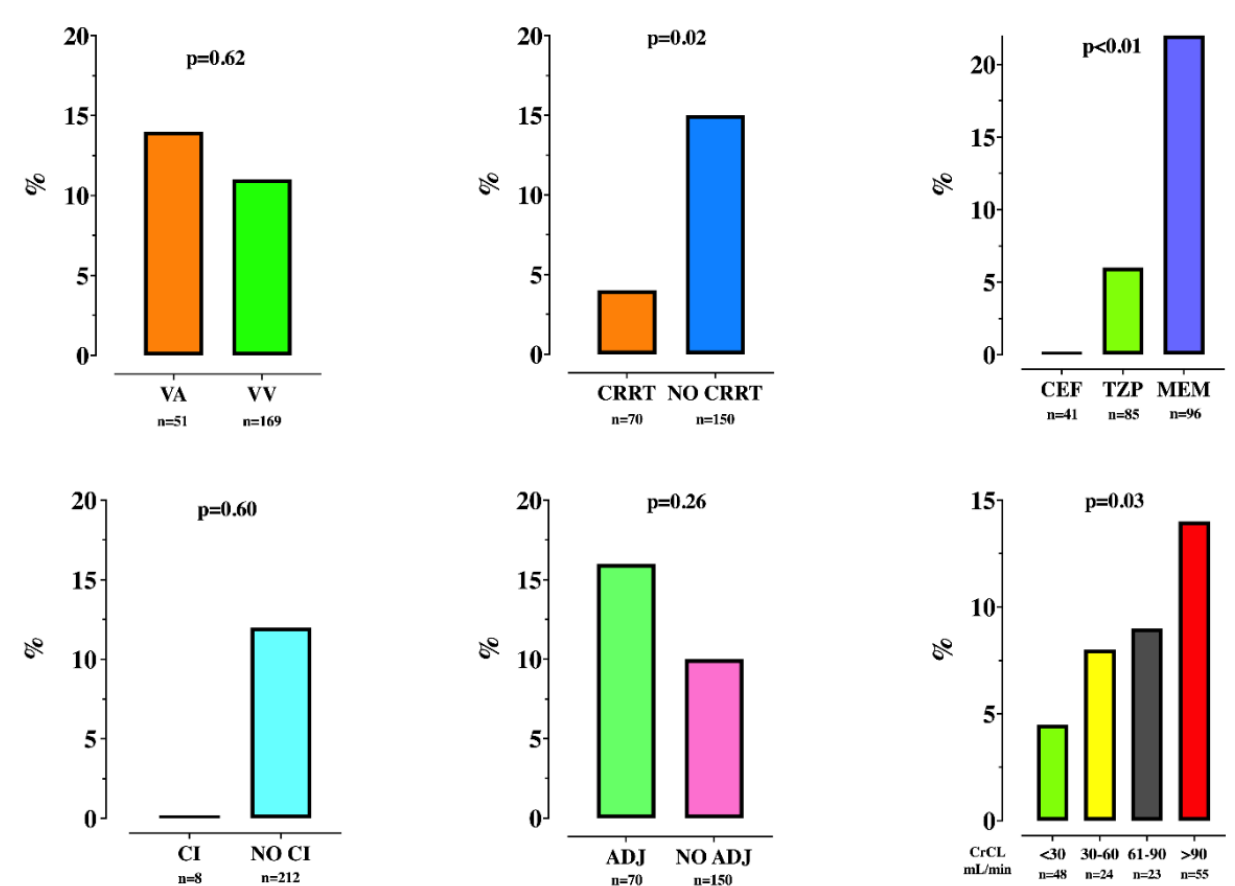
Figure 1. Proportion of therapeutic drug monitoring (TDM) with insufficient drug levels, according to various patient characteristics. VA = veno-arterial; VV = veno-venous; CRRT = continuous renal replacement therapy; CEF = ceftazidime/cefepime; TZP = piperacillin; MEM = meropenem; CI = continuous infusion; ADJ = drug regimen adapted to renal function; CrCL = clearance of creatinine.